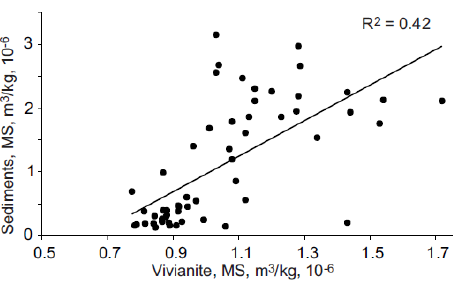
Fig. 6. Magnetic susceptibility of sediments versus magnetic sus- ceptibility of vivianite